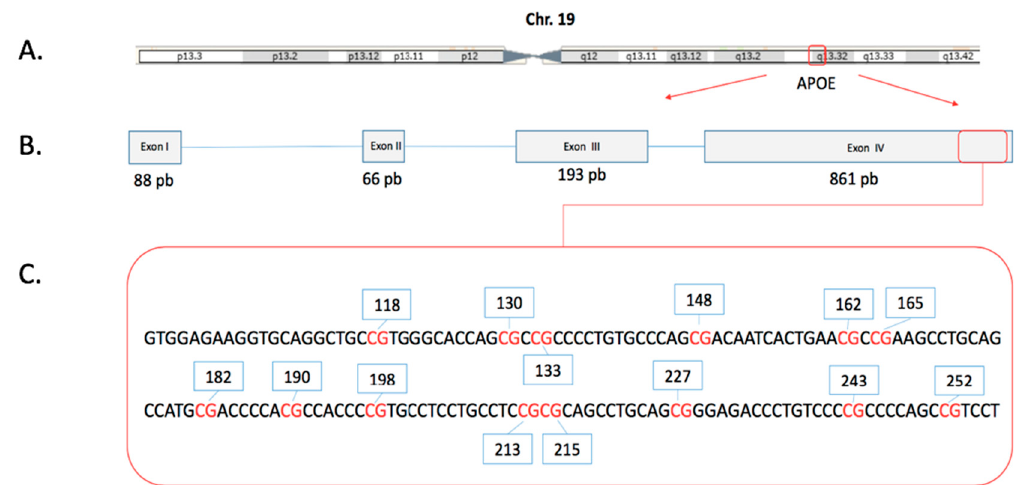
Figure 1. Schematic map of the human APOE gene. ( A ) The APOE gene contains four exons, is on the long arm of chromosome 19. ( B ) APOE gene structure (Red arrow) and the region evaluated in this study (Red box), ( C ). DNA sequence of the region evaluated by the BSP methodology, CpGs dinucleotides in red text and identification of each one in blue boxes. The genomic positions are described in Table 2.